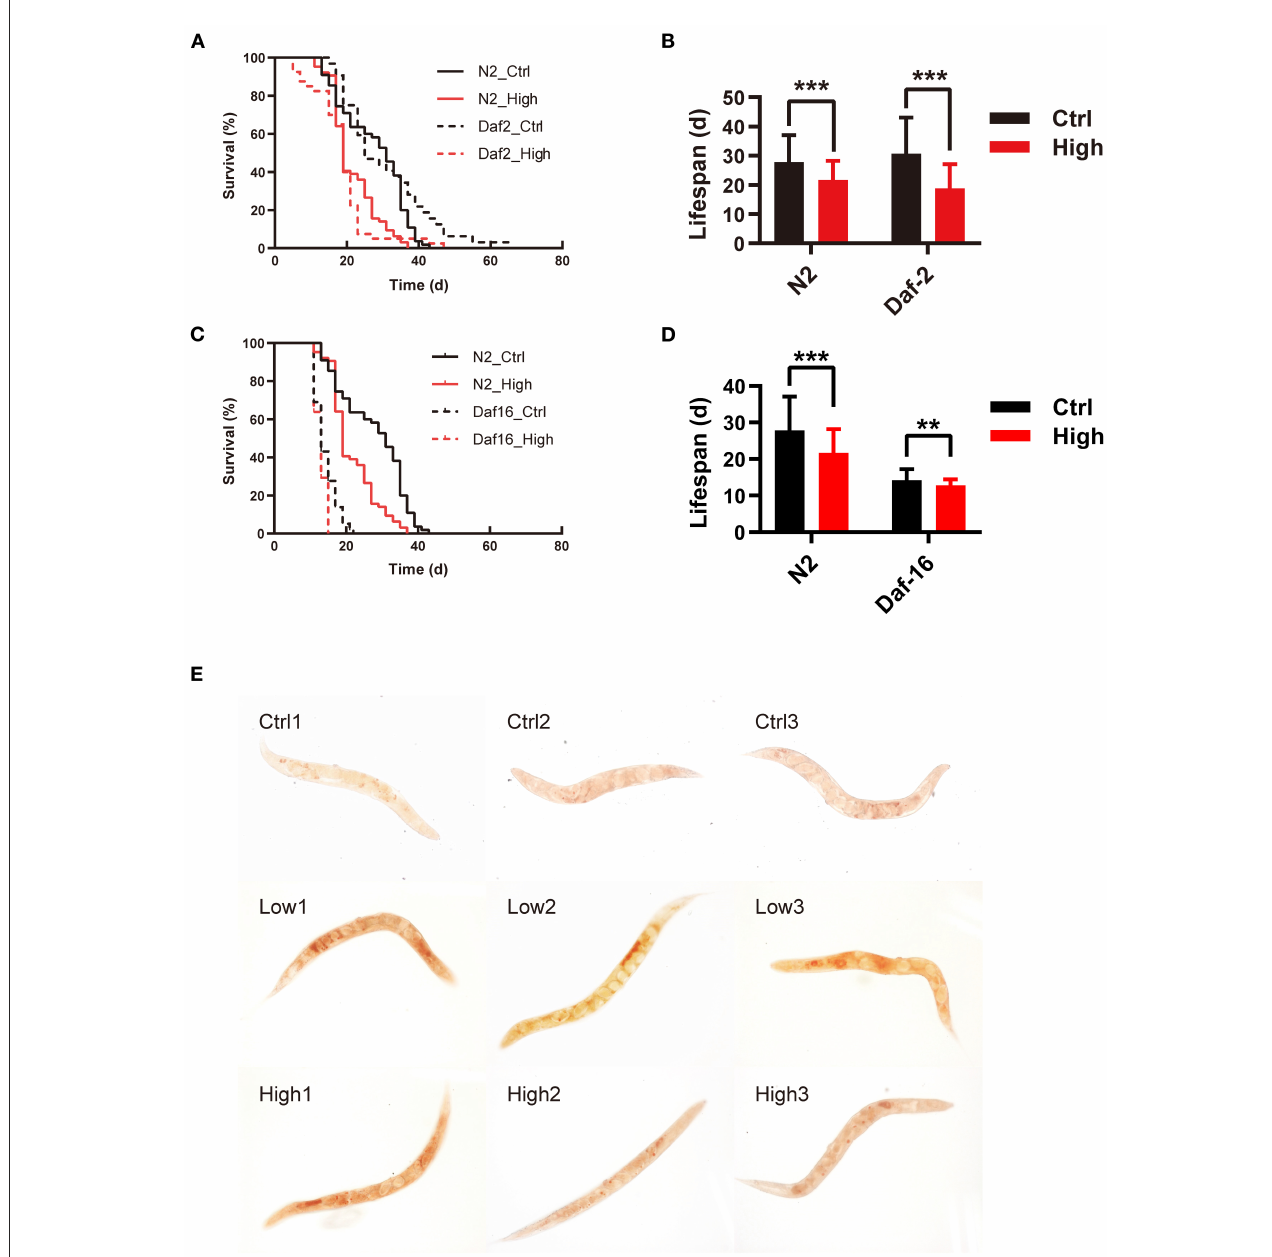
FIGURE3 WS-PM 2.5 exposure affects lifespan of daf-2 ( e1370 ) and daf-16(mu86) mutants, and disturbs neutral lipid metabolism in nematodes. (A–D) daf-2(e1370) (A, B) , daf-16(mu86) (C, D) and N2 nematodes were exposed to WS-PM 2.5 (with AQI ranging from 100 to 200 and concentration at 119 µ g/mL) throughout their life circles. Survival curves (A, C) and average lifespan (B, D) were recorded and calculated. In all groups, 60 nematodes were randomly selected for experimental manipulation. (E) Nematodes were exposed to WS-PM 2.5 for 5 d. The amount of total neutral lipids of nematodes were indicated by oil red O staining in situ (E) . All values are given as mean ± SD. Statistical significance was marked with asterisk on the top of bars of each groups vs. corresponding controls, ** p < 0.01, *** p < 0.001. “High” represents C H